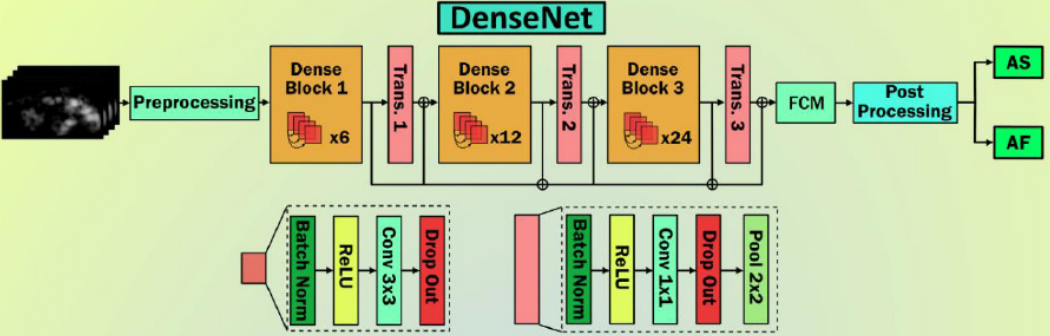
Figure A2. The general structure of Densenet architecture (courtesy of AtheroPoint™, Roseville, CA, USA)